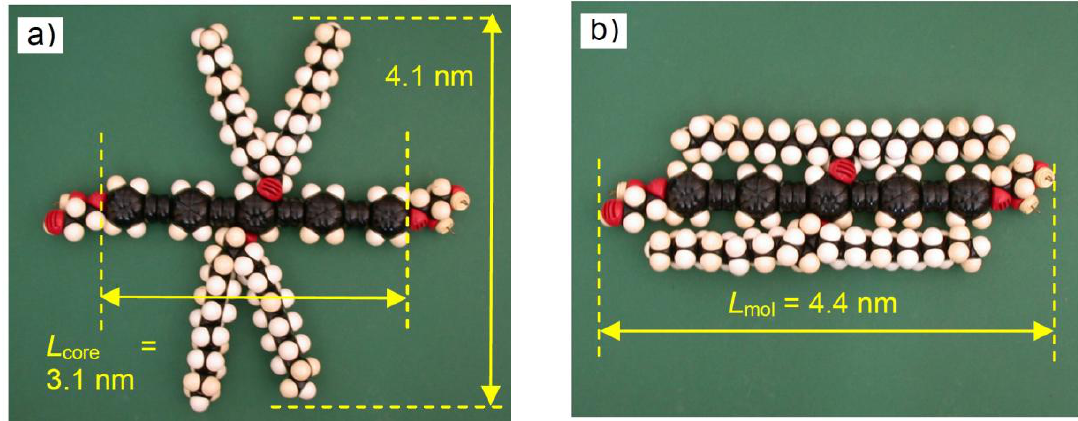
Figure 3. Molecular models showing ( a ) a star-shaped and ( b ) twinned H conformation of C12/12 with molecular dimensions.